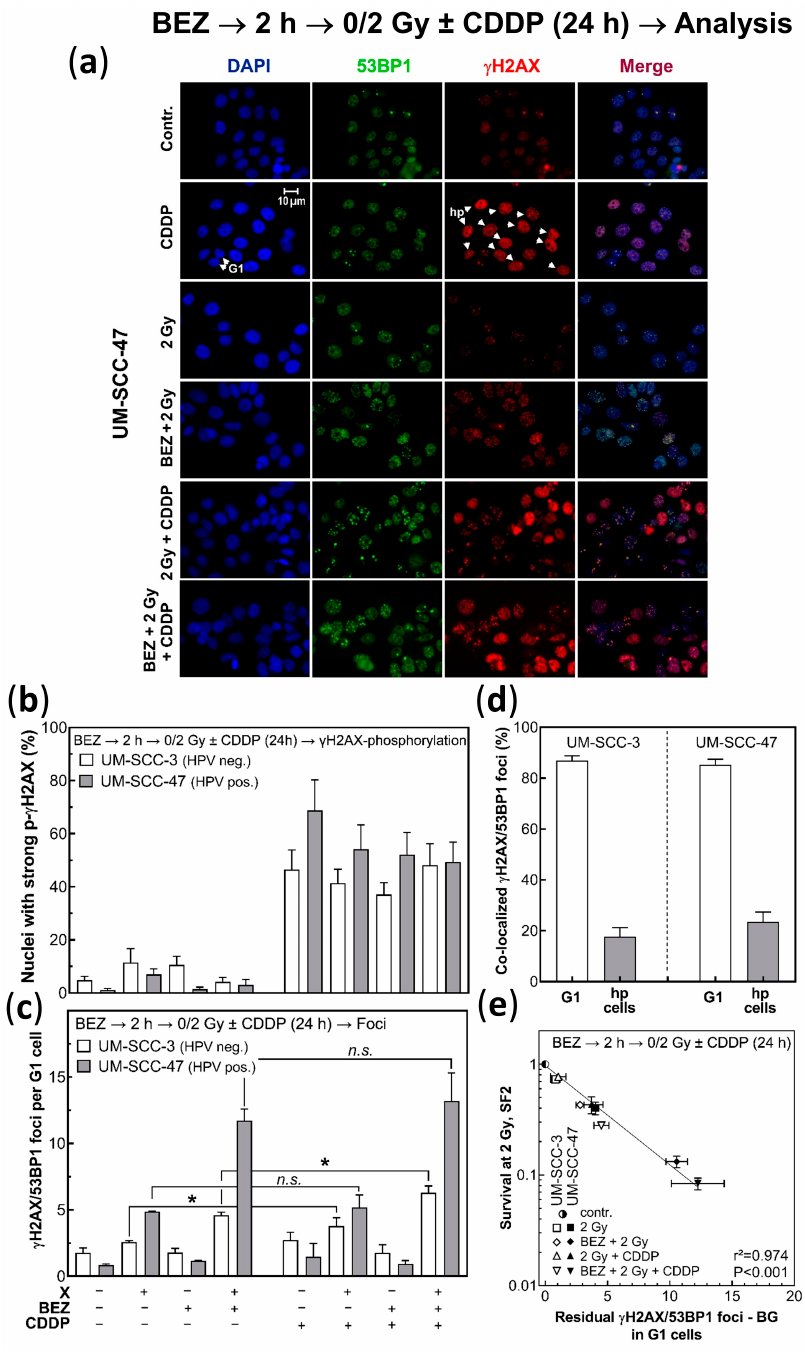
Figure 5. Effect of BEZ235 and the combined treatment with cisplatin (CDDP), and irradiation (X) on γ H2AX/53BP1 foci in UM-SCC-3 and UM-SCC-47 cells. Cells were treated with/without 50 nM BEZ235 (BEZ) 2 h before irradiation with 2 Gy and cisplatin (CDDP, IC50) treatment. ( a ) Images as taken for UM-SCC-47 cells; G1 cells, identified by a small nuclear size; hp, hyper-phosphorylation of γ H2AX with >30 foci. Enlarged images are presented in Supplementary Figure S4. ( b ) Percentage of nuclei with hp- γ H2AX. ( c ) Number of residual γ H2AX/53BP1 foci counted for G1 cells, as identified via a diameter of less than 10 µ M (see scale bar in Figure 5a). ( d ) Percentage of co-localized γ H2AX/53BP1 foci as measured for G1 cells and hp nuclei, respectively. ( e ) Association between residual number of γ H2AX/53BP1 foci after background subtraction and respective cell survival, taken from Figure 4. Data were analyzed by a log-linear regression analysis. Data are presented as mean values ± SEM, n ≥ 2, per value at least 100 cells are counted; * p = 0.05; n.s. : non significant.